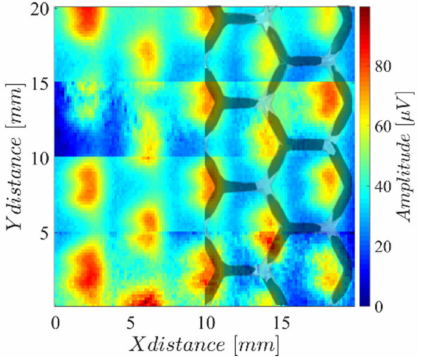
Figure 17. Amplitude imaging result measuring the array probe on a two-dimensional scan over the 3D hexagonal lattice surface of the LPBF-produced